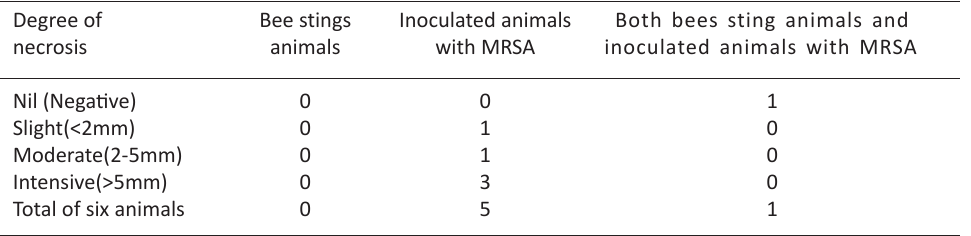
Table 2. Appearance of the necrosis on the skin of six adult rabbits after stings with honey bee venom and subcutaneous inoculation with MRSA. Degree of Bee stings Inoculated animals Both bees sting animals and animals with MRSA inoculated animals with